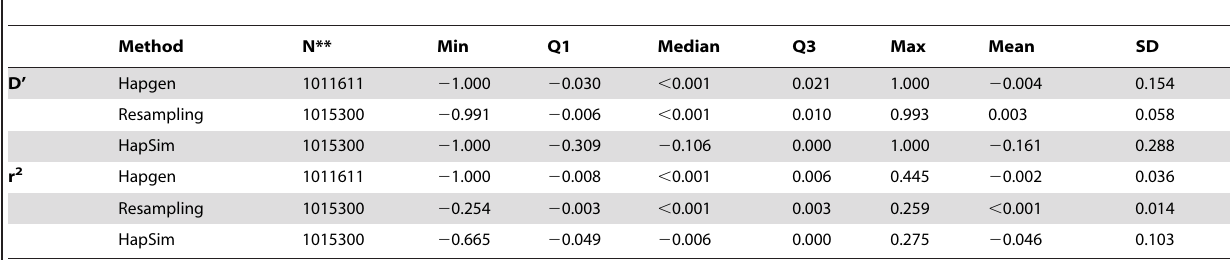
Table 4. LD–Gene Region